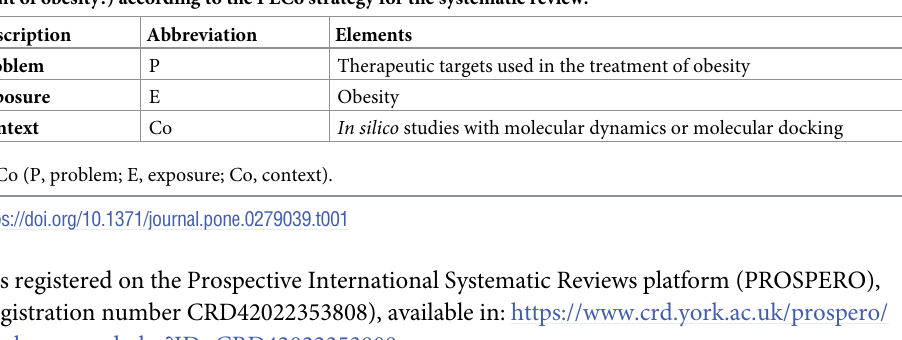
Table 1. Research question structure (What therapeutic targets have been used in in silico analysis for the treat- ment of obesity?) according to the PECo strategy for the systematic review.